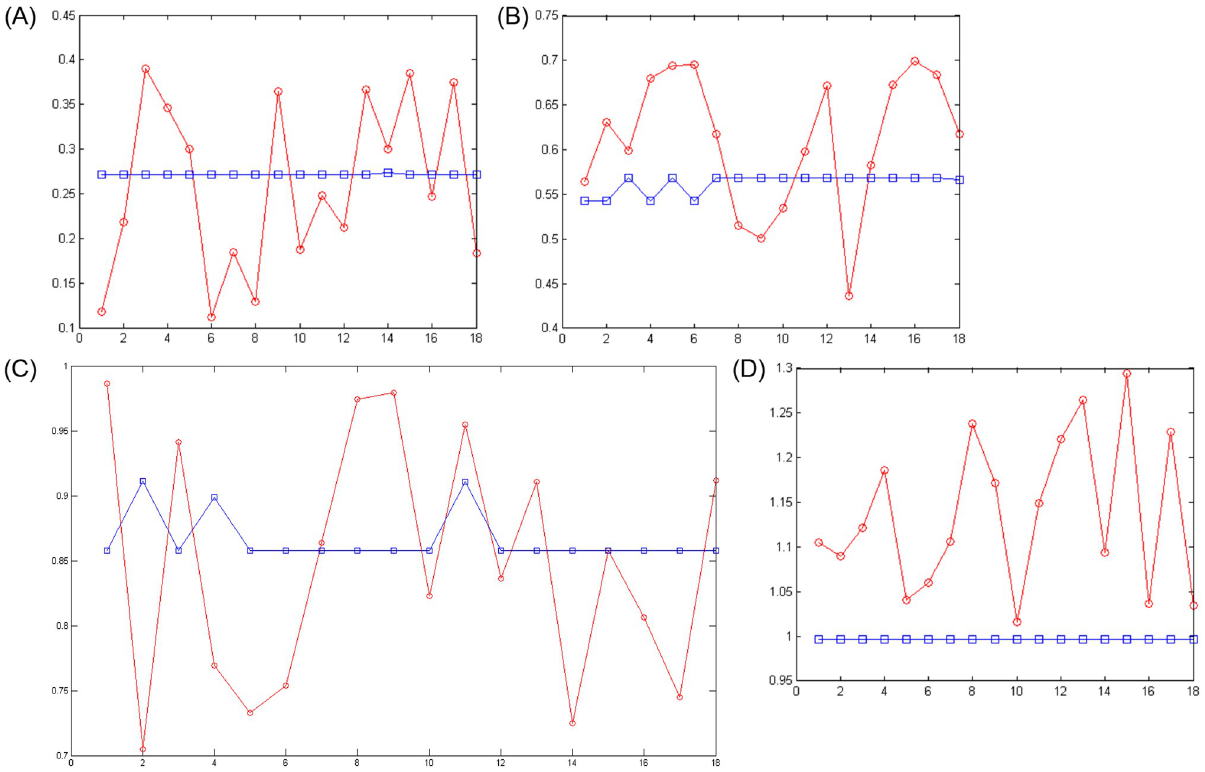
Fig 5. The distance of the obtained answer (blue chart) in each generation change in ANN-BTA compared to the real answer (red chart) in test samples: (Fig 5A)[0.1, 0.4], (Fig 5B)[0.4, 0.7], (Fig 5C)[0.7, 1] and (Fig 5D)[1, 1.3] range.